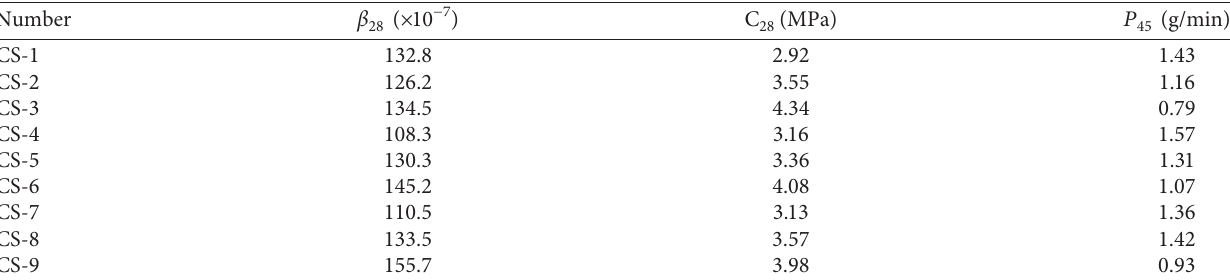
Table 7: Orthogonal design and the results of experiment.